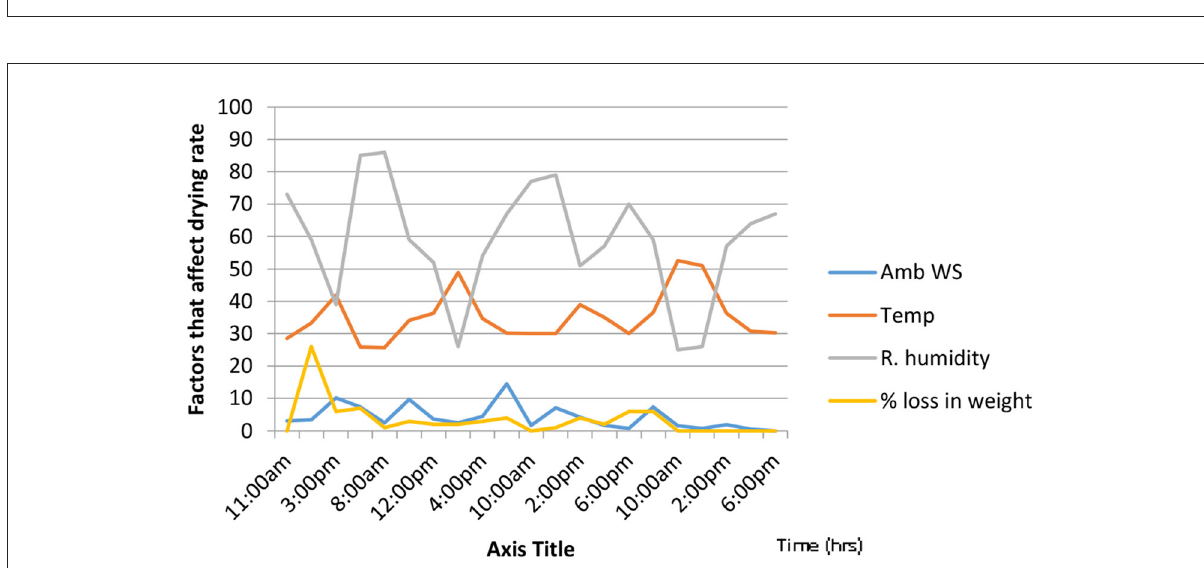
FIGURE6 Changes during the solar drying of unfermented cocoa beans. Temp, temperature ( o C); Ambws, ambient wind speed (m/s); % loss in wt, % loss in weight; humidity (g/m 3